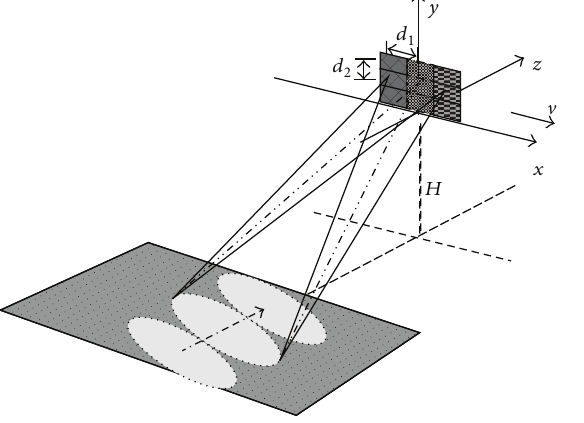
Figure 1: MIMO-SAR